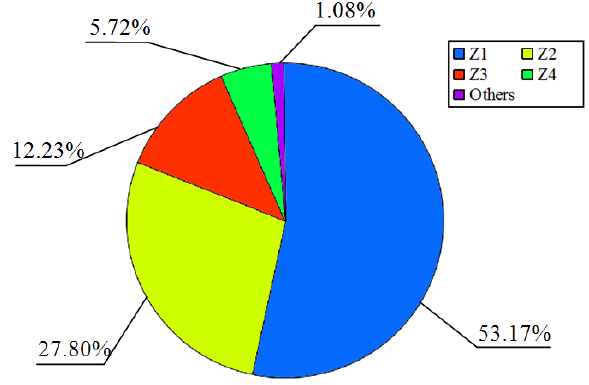
Figure 3. CONTRIBUTION RATIO distribution of the principal